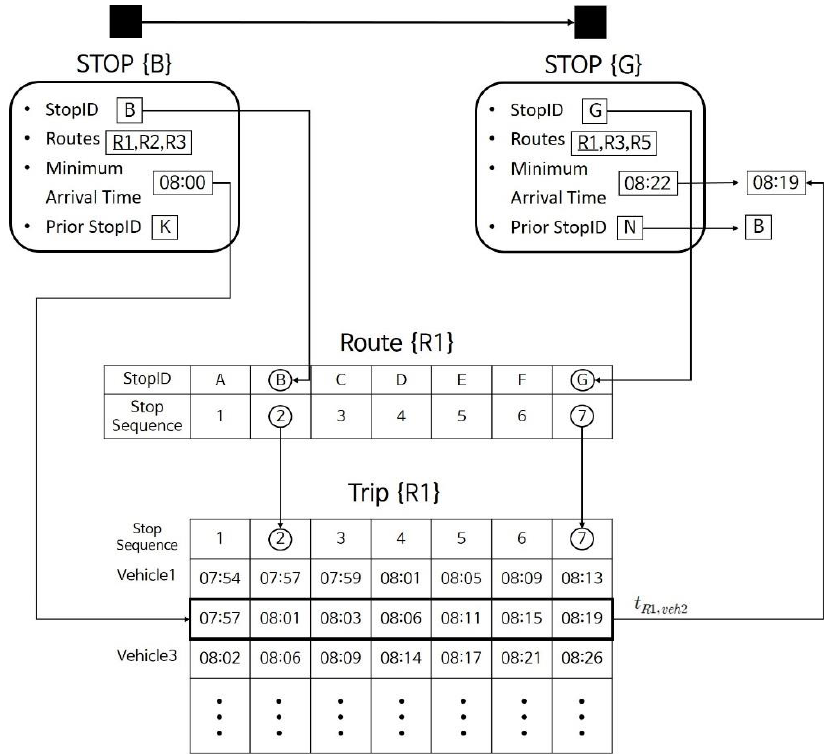
Figure 1. Example of data structure in RAPTOR